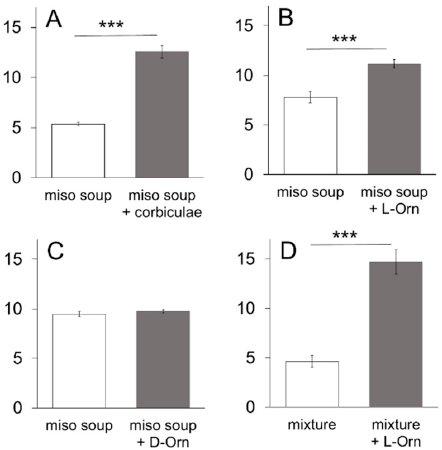
Figure 1. Two-bottle preference test using miso soup or a taste mixture in the presence or absence of corbiculae, L-ornithine (L-Orn), or D-ornithine (D-Orn). Fluid intake (mean ± SE; n = 8) is compared between miso soup and miso soup with corbiculae ( A ), L-Orn ( B ), or D-Orn ( C ), and between a taste mixture with or without L-Orn ( D ). The taste mixture is an aqueous solution consisting of 0.05 M MSG, 0.05 M sucrose, and 0.05 M NaCl. *** p < 0.001.